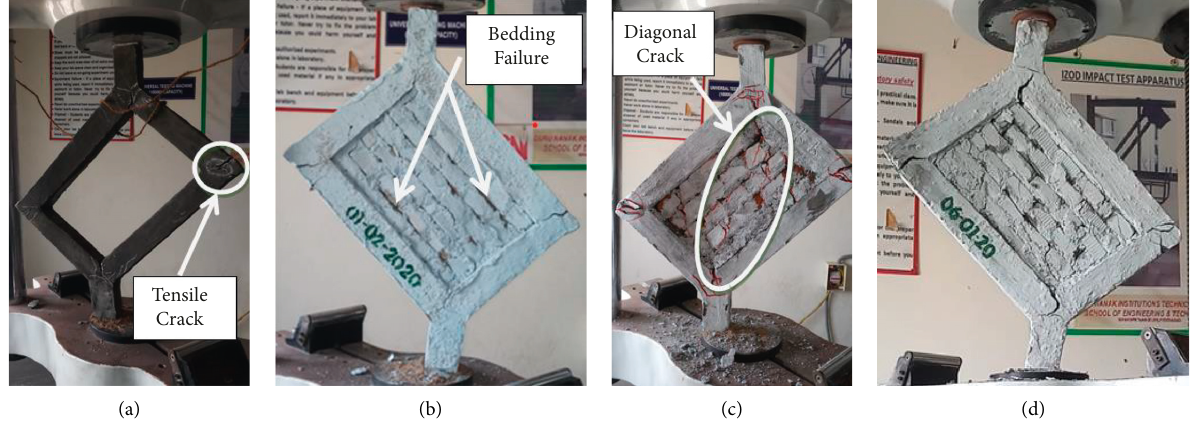
Figure 10: (a) Bare frame. (b) Failure of IF-CBM. (c) Failure of IF-CBM. (d) Failure of